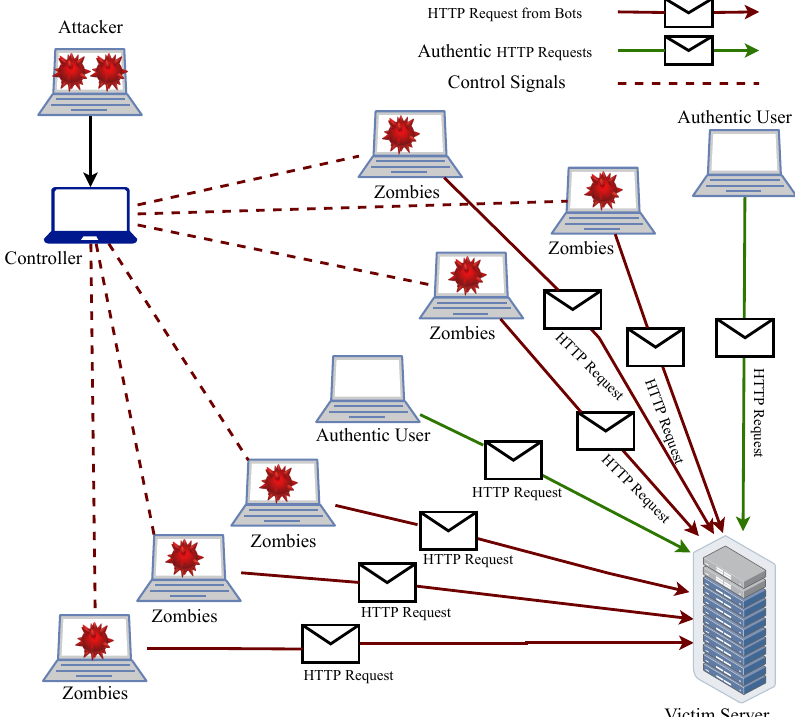
Figure 1. Schematic diagram of a DDoS